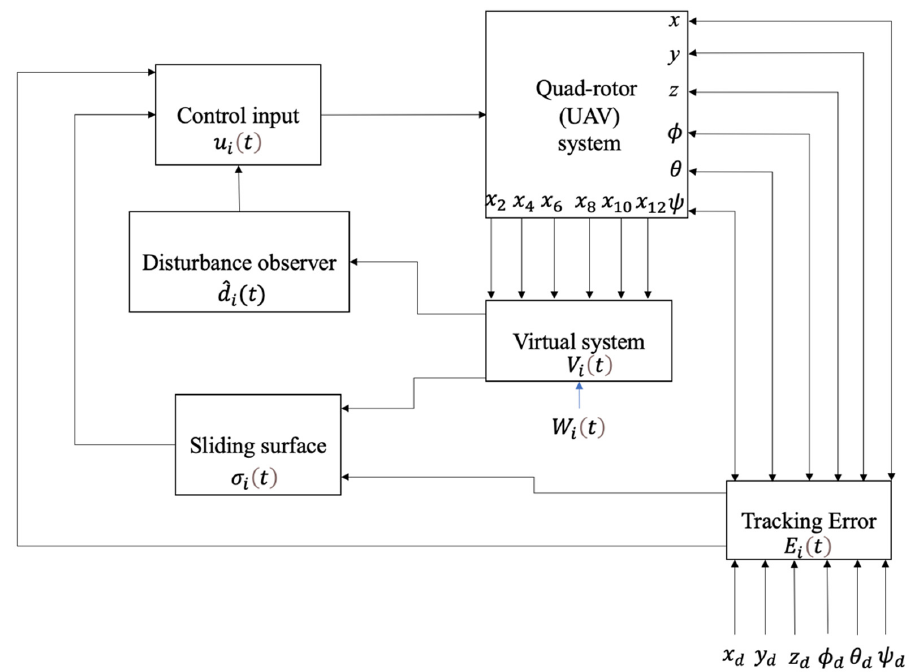
Figure 1. Block diagram of non ‐ singular terminal SMC based on disturbance observer.